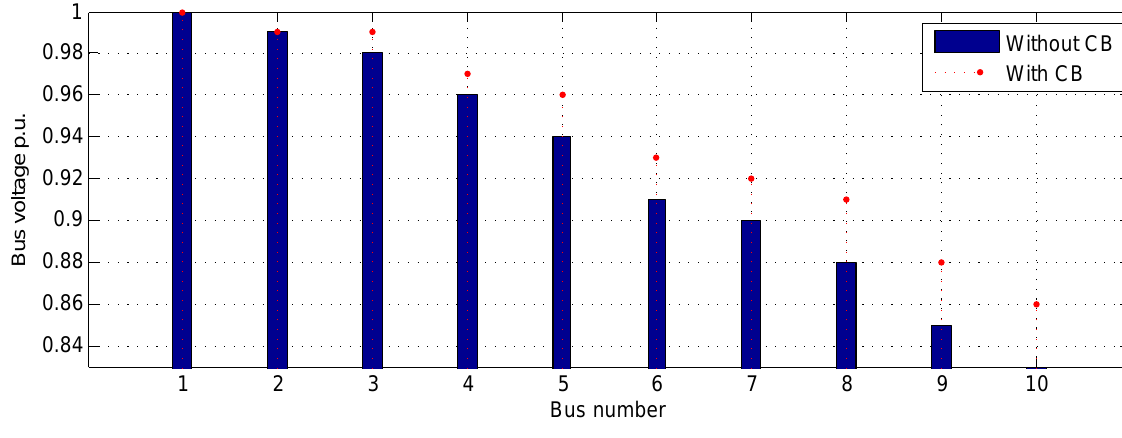
Figure 4. Voltage profile: 10-bus system.